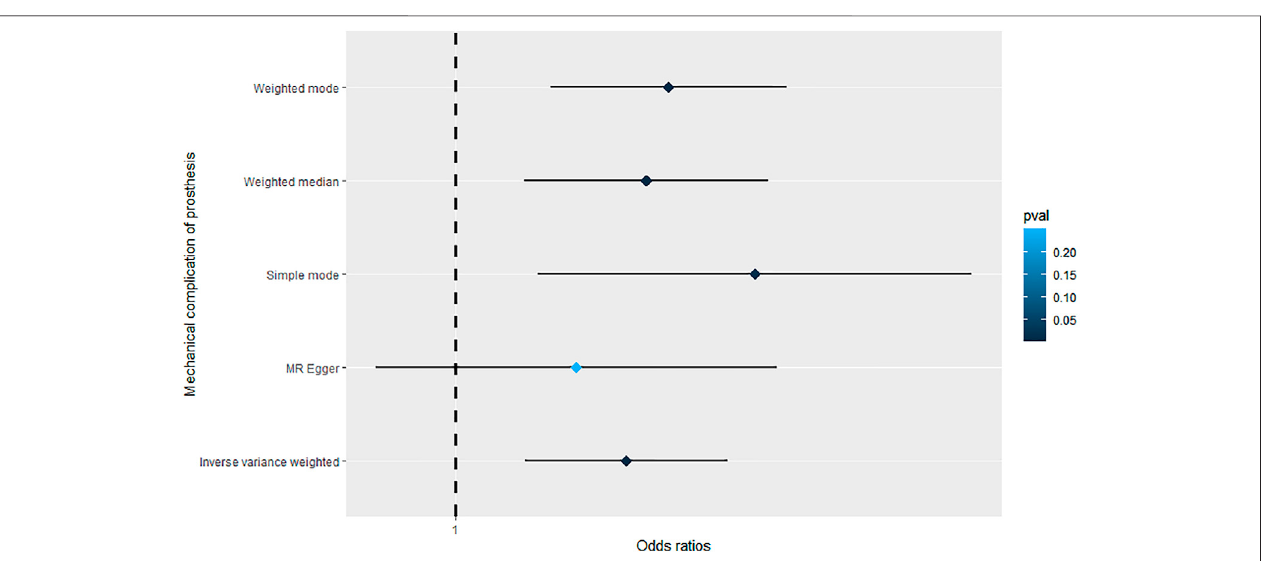
Frontiers in Genetics |